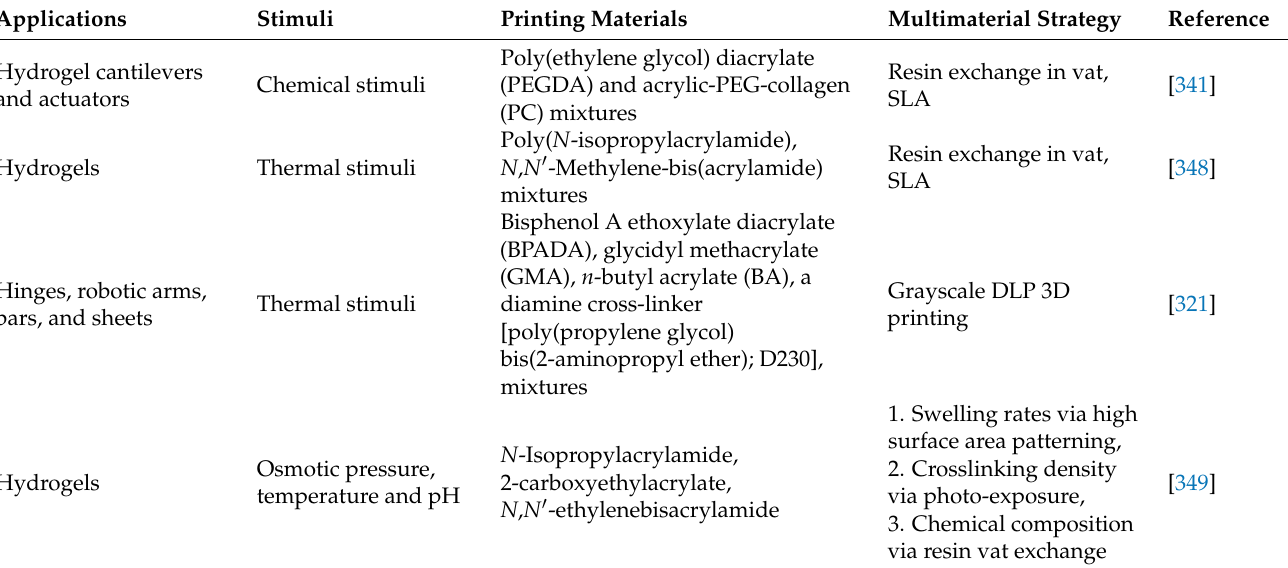
Table 7. Stimuli-responsive materials printed by multi-material vat